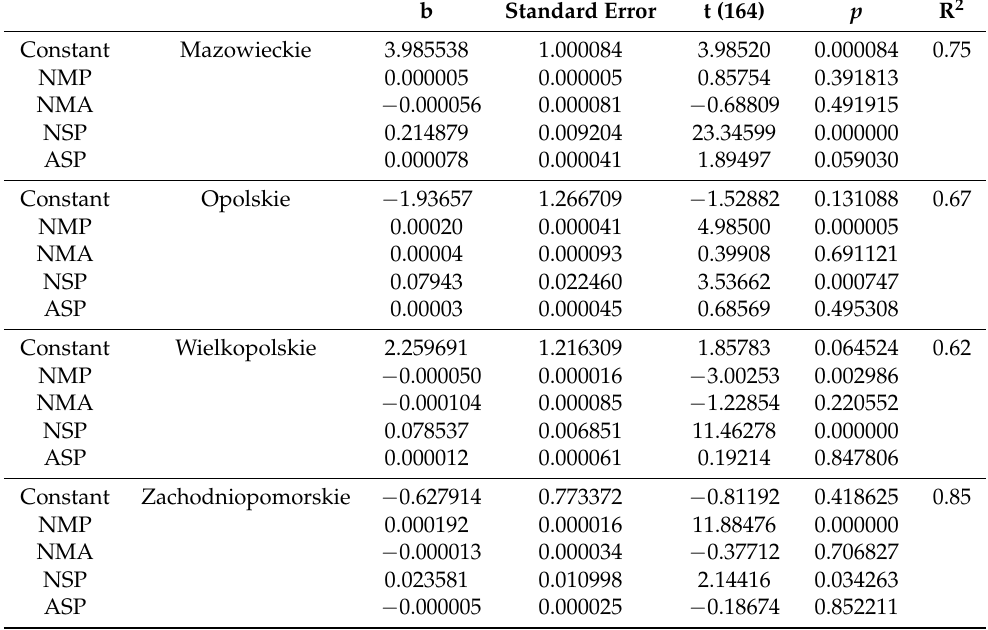
Table 4. Estimation of linear regression model parameters for selected provinces (N =